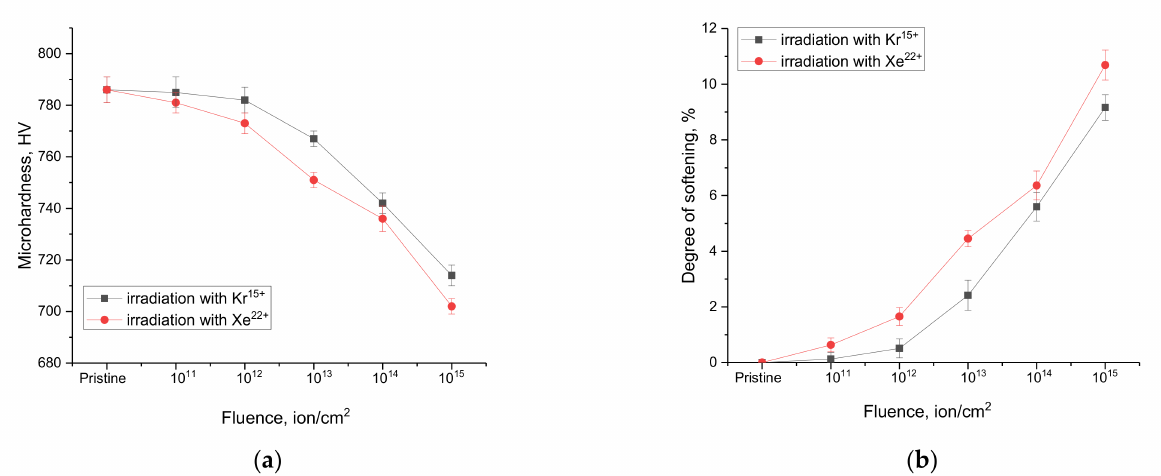
Figure 7. ( a ) Results of the change in the microhardness value depending on the irradiation fluence; ( b ) Results of the change in the softening